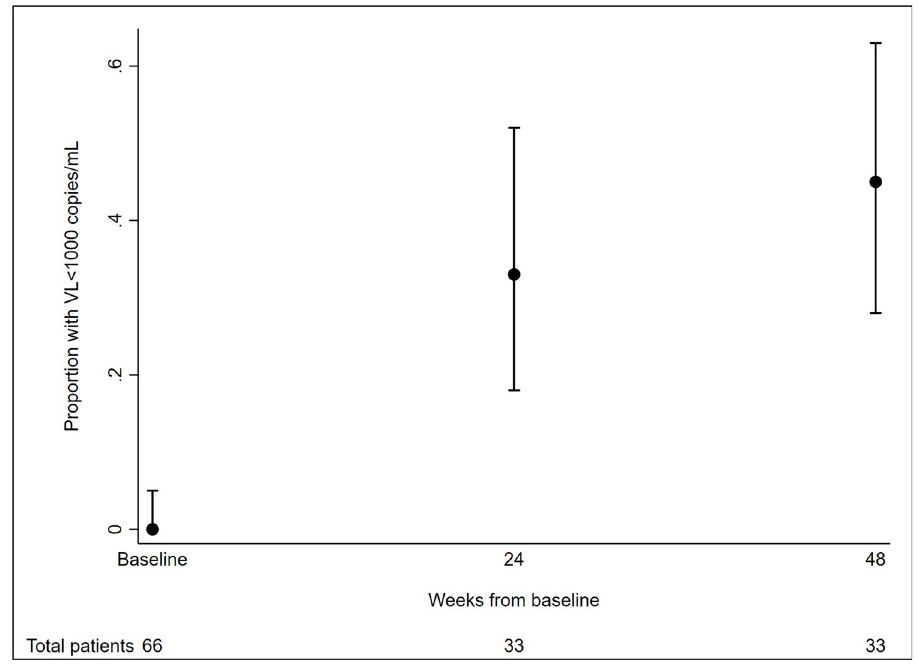
Fig 3. Proportion of undetectable viral load in patient with holding regimens. VL: Viral load.